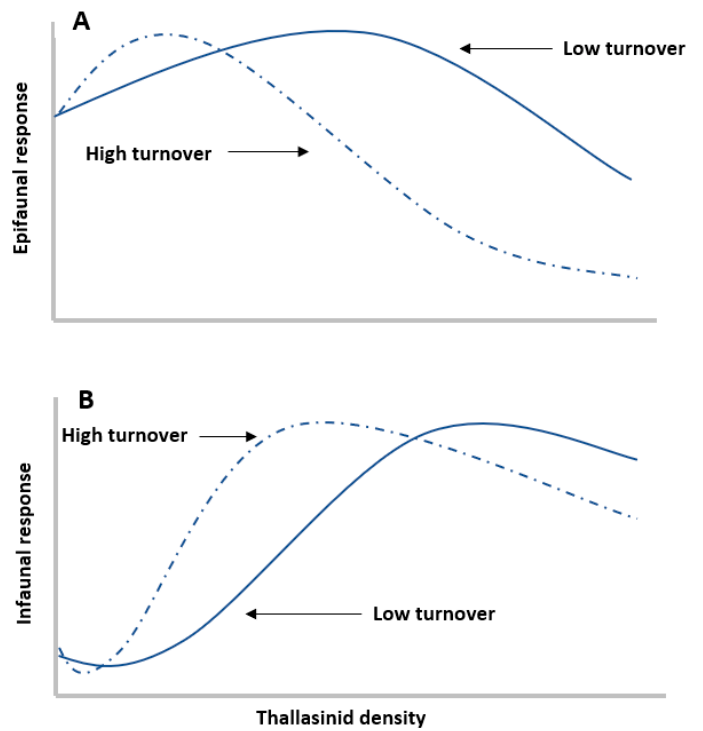
Figure 4. Predicted responses of ( A ) epifauna and ( B ) infauna to increasing densities of two deposit-feeding thalassinid species that exhibit contrasting sediment processing behaviours. Species that exhibit high turnover (broken lines) rates induce changes in direction of infaunal and epifaunal responses at lower densities than those that exhibit low turnover (solid lines). Note: responses are intended to be illustrative, not exhaustive – broad patterns are more important than specific response features.